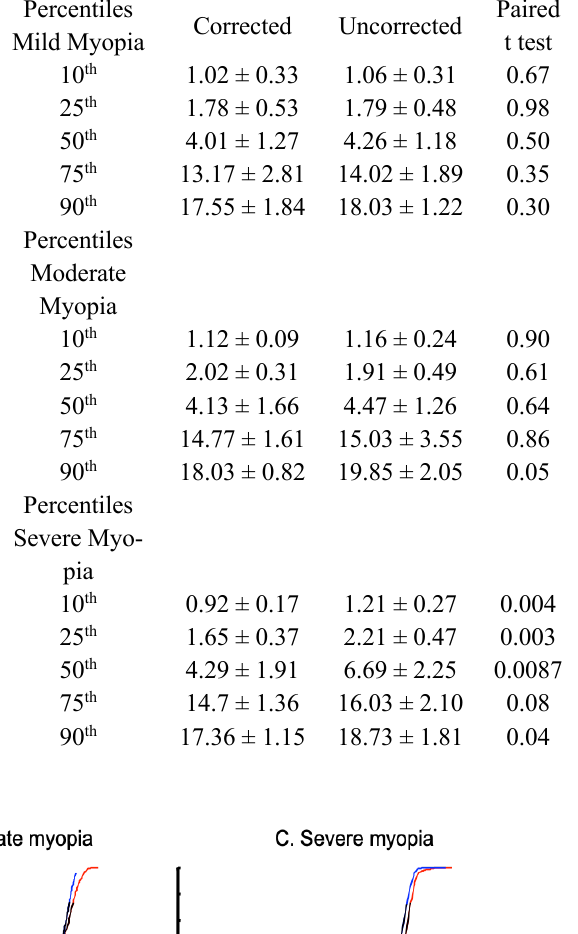
Table 2: Percentile Amplitude of Microsaccade/Saccade elicited in the right eye of subjects in corrected and un- corrected state as a function of severity of myopia during visual search task.